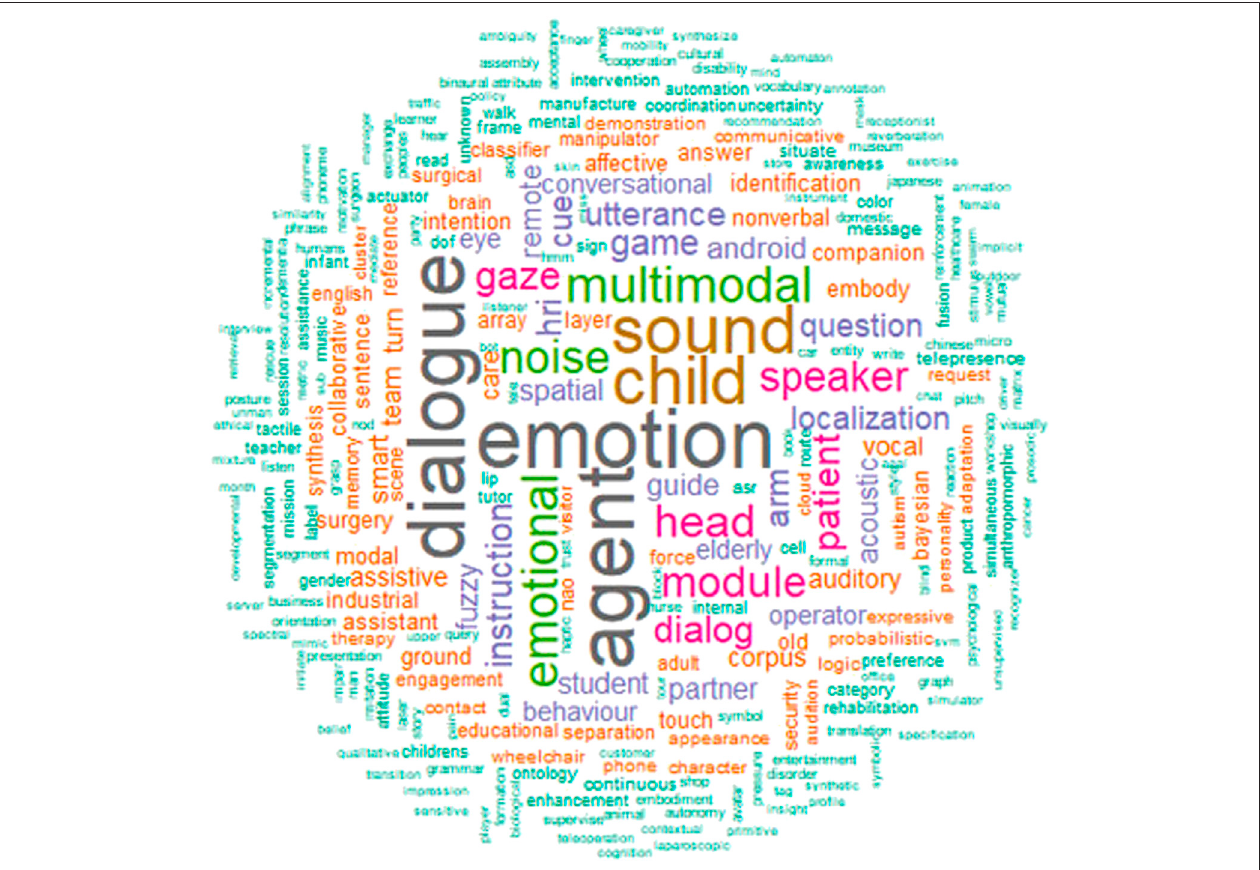
FIGURE 4 | Wordcloud of most frequent words for the text fi ltered with tf-idf.